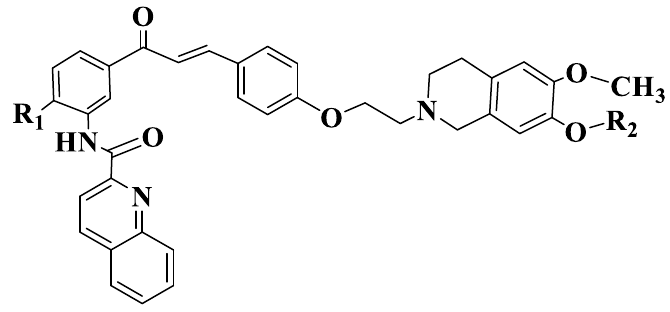
Figure 6. General structure of tariquidar-chalcones (compounds 132 – 137